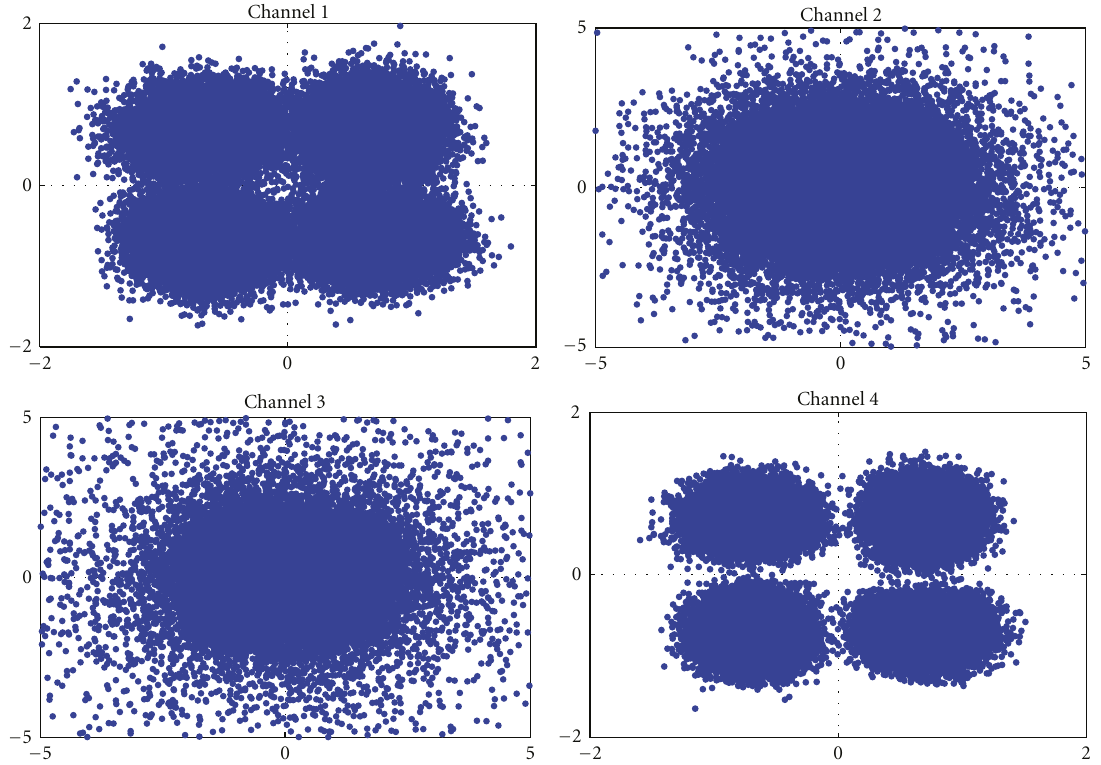
Figure 14: Scatter plots for 10 6 symbols of the four input signals after channel tracking (recorded along path 1, NLoS, 0 . 5m/s) show the substantial channel variation during the transmission of the data burst.